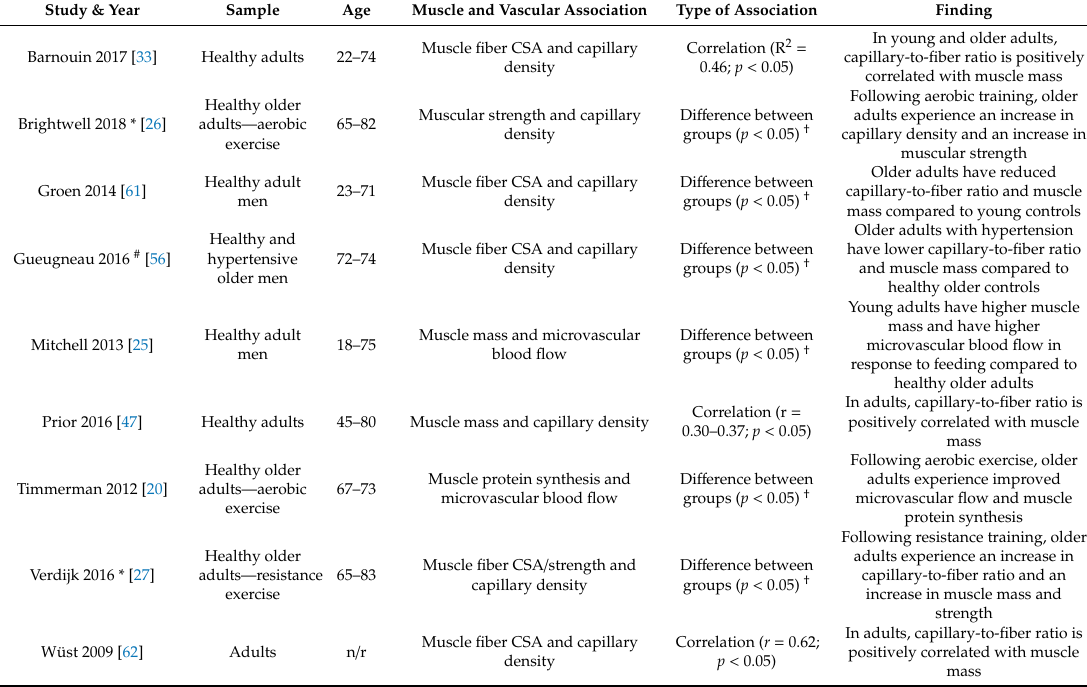
Table 5. Association between skeletal muscle and microvascular blood